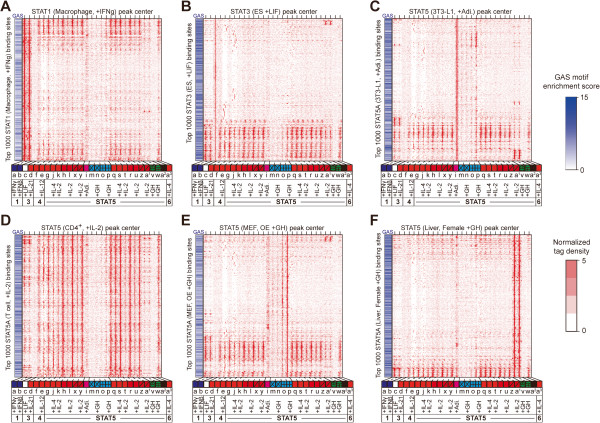
Shared and distinct sites of occupation. Hierarchical clustering (average linkage algorithm) was performed with normalized ChIP-seq tags (tags per 10 million), which are located within +/− 1.5 kb flanking regions of the top 1000 STAT peak centers (determined by height of peaks in each condition). GAS motifs were identified within +/− 75 bp flanking regions of the top sites using the MOODS algorithm (p value < 0.01) [26]. Rows represent the top 1000 STAT binding sites in the given cell type (top label) and red vertical lines in tracks indicate the binding of STAT under specific conditions (bottom labels). (A) STAT1 peak centered in macrophages with IFNγ stimulation. (B) STAT3 peak centered in ES cells with LIF stimulation. (C) STAT5 peak centered in 3T3-L1 cells with adipogenic inducers. (D) STAT5 peak centered in T cells with IL-2 stimulation. (E) STAT5 peak centered in STAT5A overexpressing MEF with growth hormone. (F) STAT5 peak centered in female liver with growth hormone.